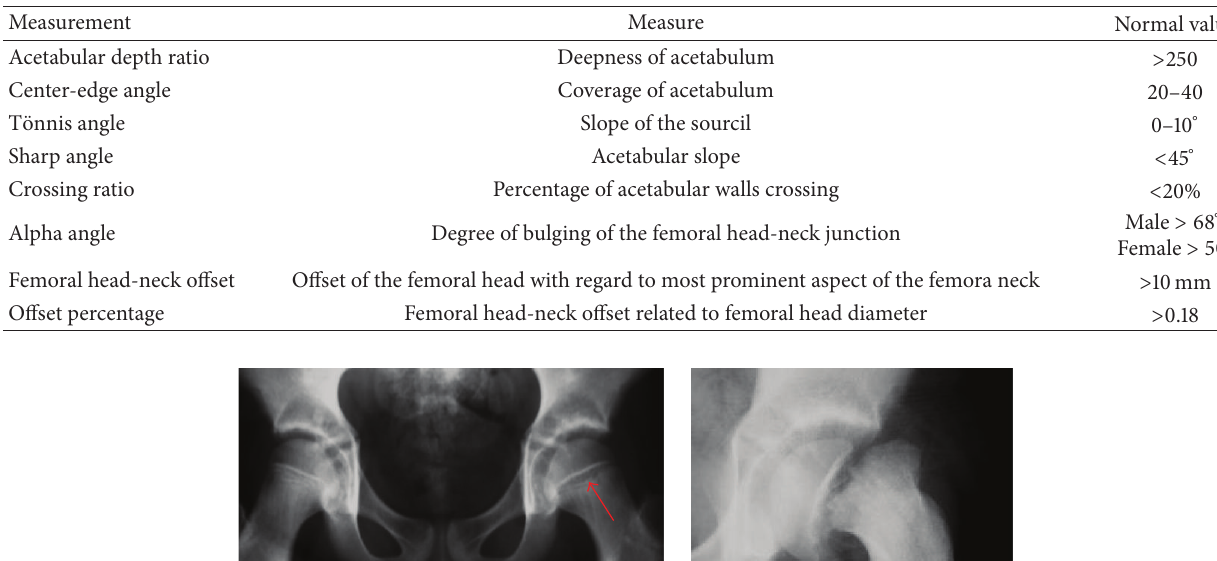
Table 1: Measurements in adult hip.